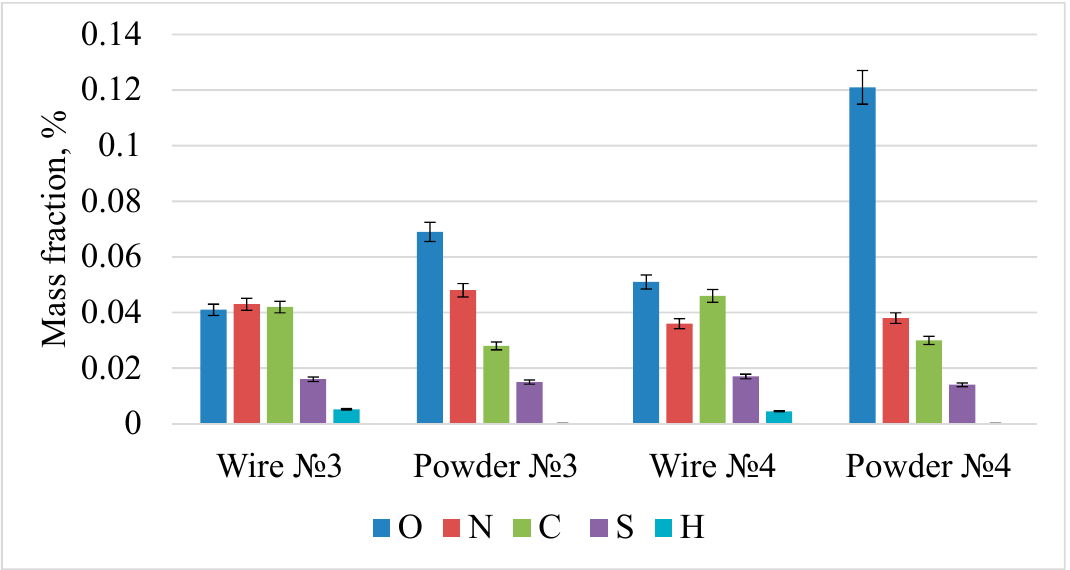
Figure 11. The results of the analysis of the impurity composition of samples 3 and 4. A study of the microhardness of the ingots and powder particles was carried out. The results are shown in Figure 12. The measurement results showed that, with an increase in silver in the ingot and powder particles, the hardness decreases, which is explained by the introduction of a softer component into the composition of the corrosion-resistant steel.